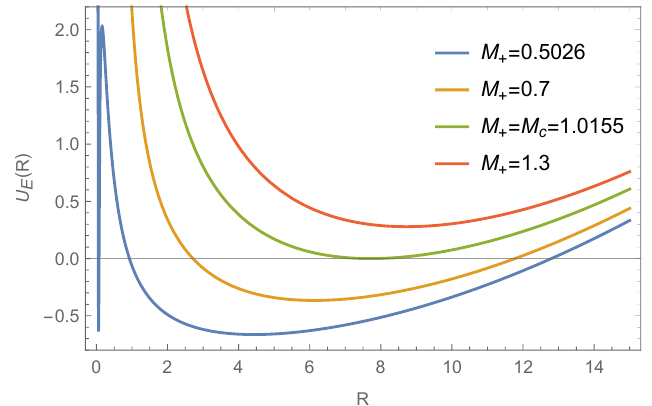
, and M c = 0 . 0863 . 16 πG